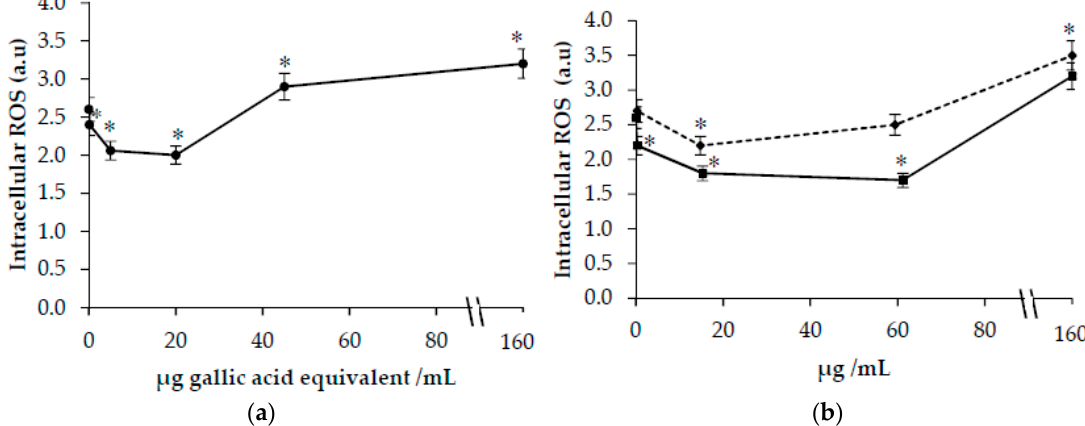
Figure 4: Intracellular ROS formation in HuDe cells treated with the pro-oxidant tert-butyl hydroperoxide ( t -BOOH) (50 μ M) in the presence of increasing concentrations of Carthamus Tinctorius (CT) extract (a) or hy- droxy safflor yellow A (HSYA) ( ) and safflor yellow A (SYA) ( ) ( b ). Phenolic concentrations of CT extract are expressed as μ g gallic acid equivalent/mL. * p < 0.05 vs. cells treated with t-BOOH in the absence of CT extracts or SYA and